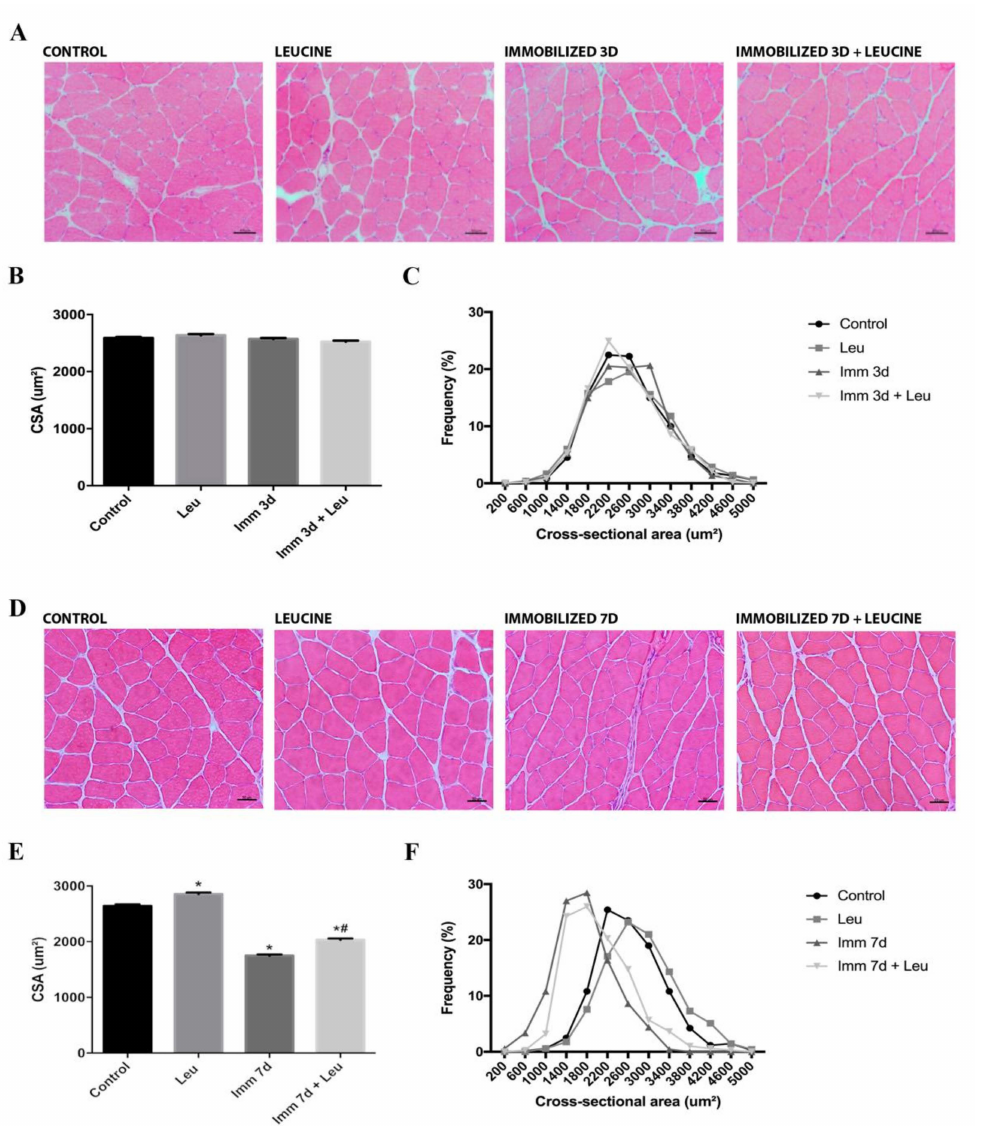
Figure 1. Morphometric analysis after 3 and 7 days of immobilization and leucine supplementation. ( A ) Representative hematoxylin–eosin staining (HE) photomicrographs in soleus muscle after 3 days of immobilization ( n = 4, scale bar 50 µ m). ( B ) Soleus muscle average fiber cross-sectional area (CSA) and ( C ) distribution from control, leucine supplemented, immobilized, and immobilized supplemented with leucine after 3 days ( n = 4). ( D ) Representative HE photomicrographs in soleus muscle after 7 days of immobilization ( n = 5, scale bar 50 µ m). ( E ) Soleus muscle average fiber CSA and ( F ) distribution from control, leucine supplemented, immobilized, and immobilized supplemented with leucine after 7 days ( n = 5). Data were expressed as mean ± SD. Statistical analysis included Kruskal-Wallis test of one-way ANOVA followed by Dunn’s posthoc test. Two independent experiments were performed. * p < 0.05 vs. Control group; # p < 0.05 vs. Immobilized 7 d